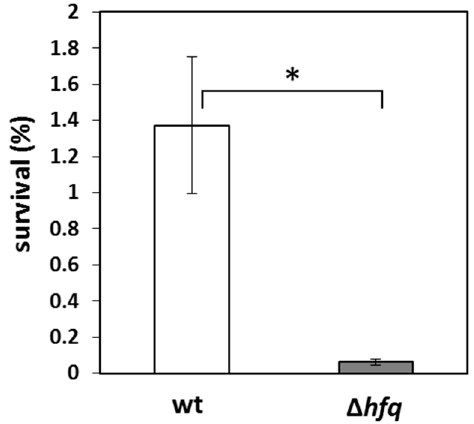
Figure 5. Serum killing assay of ∆ hfq and Tohama I strains. Serum resistance is expressed as percentage of wt (white bar) and ∆ hfq (grey bar) cells that survived upon incubation with 10% human serum when compared to controls (bacteria incubated with heat-inactivated serum). The error bars represent the standard deviation of the mean obtained from three biological replicates (*, p < 0.001). The result is representative of three independent